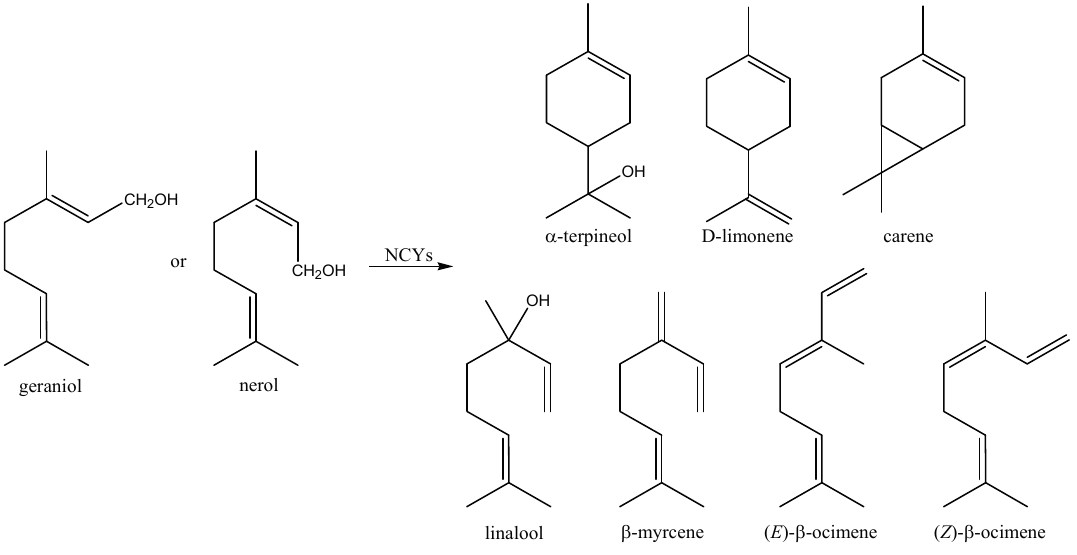
Figure 9. Bioconversion of geraniol and nerol by whole-cells of Debaryomyces , Kluyveromyces , and Pichia